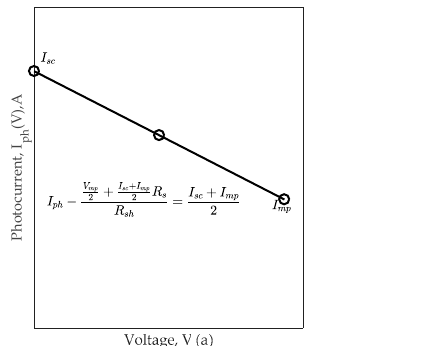
Figure A1. Volt-ampere curves and their quadratic equivalent in range V mp ≤ V ≤ V oc for first three experiments as an example of an alternative procedure. ( a ) Experiment No.1, ( b ) Experiment No.2, ( c ) Experiment No.3.